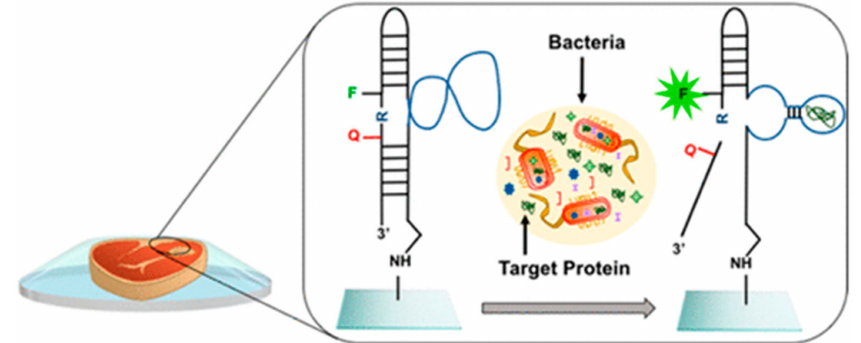
Figure 10. Fluorescent DNAzyme probe with specific binding characteristics for E. coli was printed on cyclo-olefin polymer transparent package (reprinted with permission from Reference [112]. Copyright 2018, American Chemical